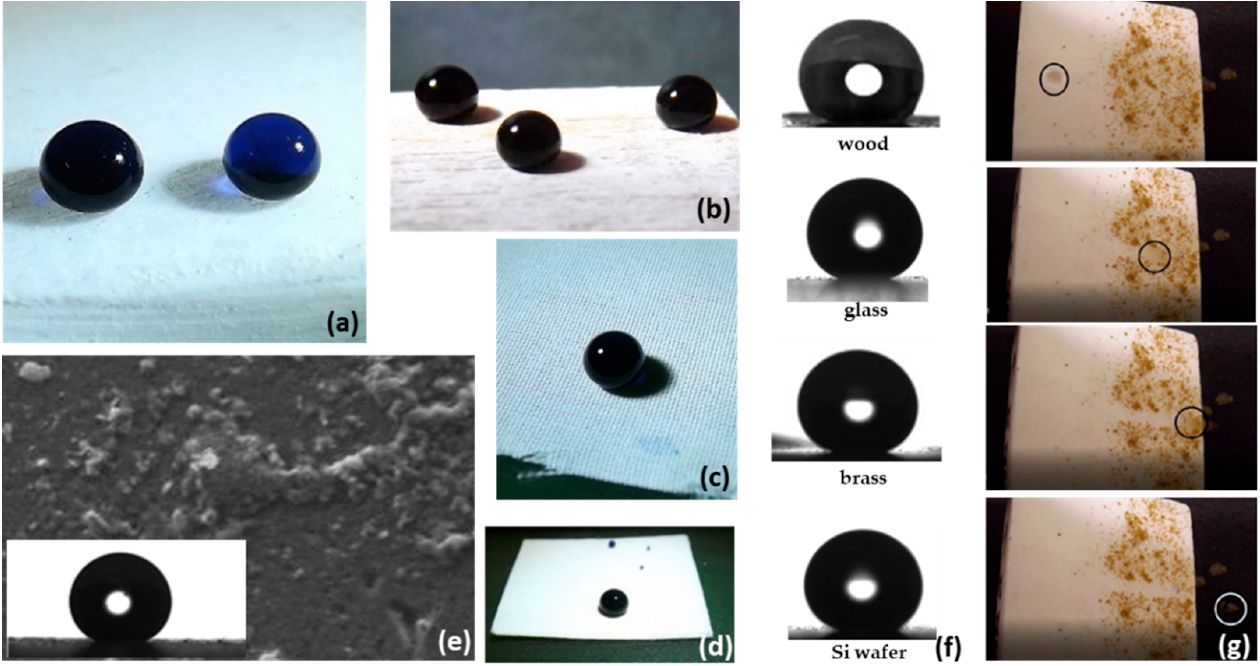
Figure 2. Photographs of water drops on coated ( a ) marble, ( b ) wood, ( c ) silk and ( d ) brass. ( e ) SEM image of the surface of coated marble and a side photograph of a water drop. ( f ) Side photographs of water drops on various coated substrates. ( g ) The easy/self-cleaning scenario is revealed in the subsequent snapshots from top to bottom. The motion of a water drop is captured by the circles.